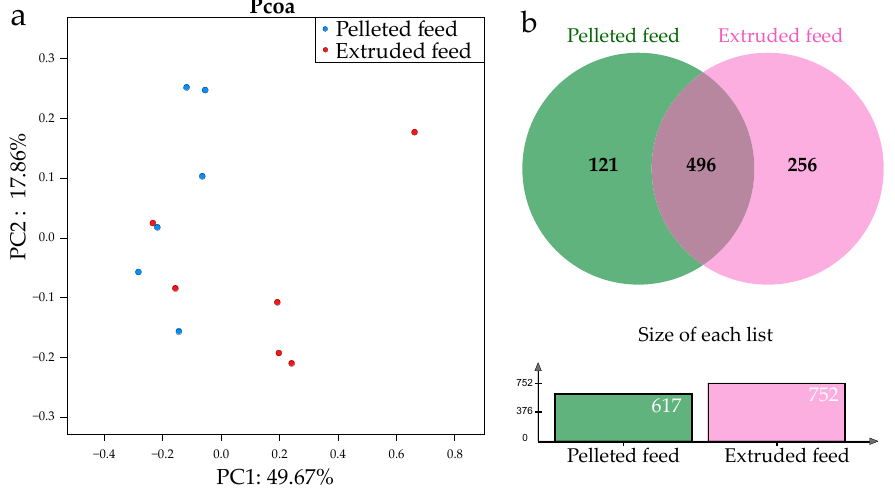
Figure 2. ( a ) Principal coordinate analysis (PCoA) of intestinal bacterial communities of P. clarkii fed pelleted feed and extruded feed; based on weighted UniFrac distances, each point represents a sample, and different colors represent different diets. ( b ) Venn diagram showing shared and unique OTUs of P. clarkii fed different diets.